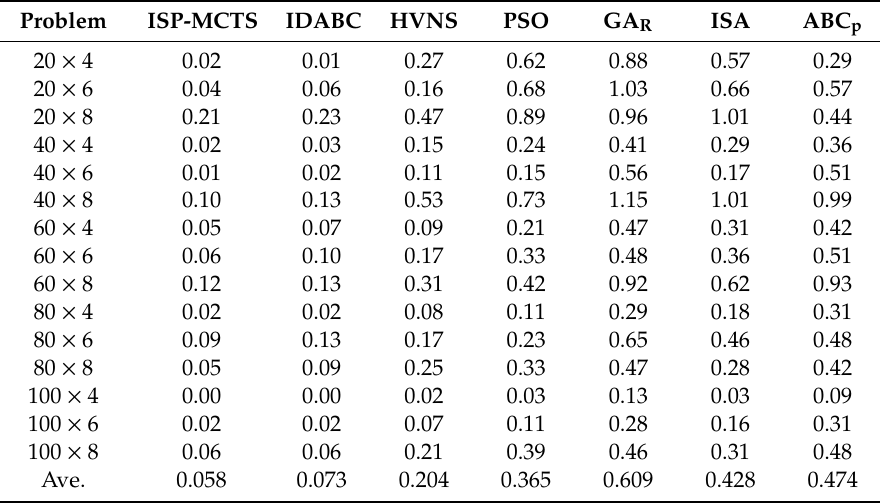
Table 10. Computational results of the algorithms ( ρ =